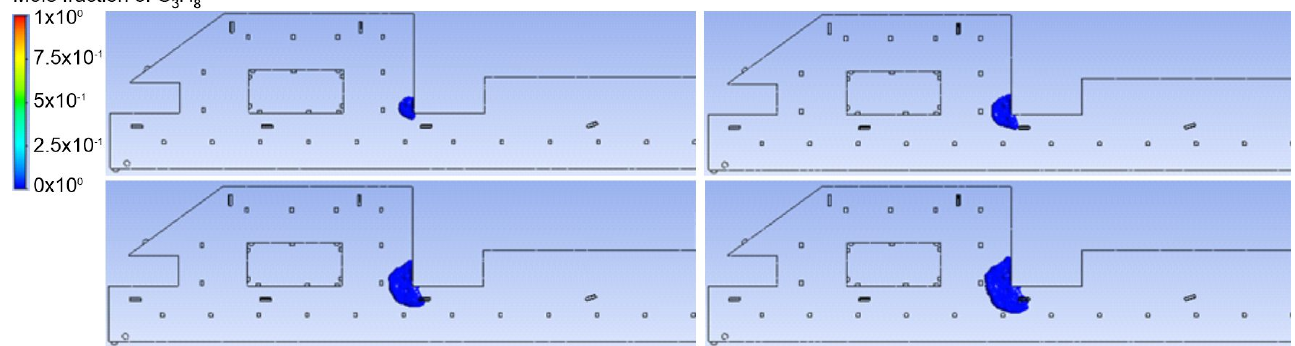
Figure 6. Lower explosive limit of LPG distribution in an underground garage after gas dispersion for B source for different time steps: 2.5 s, 5 s, 7.5 s and 10 s. For longer times, differences in gas dispersion were observed. For A source, a greater area occupied by gas compared to B source was observed. For the A leakage source, the equal to 15 s). Next, the LEL area expanded to 6.1%, 5.6% and 5.1% for 35 s, 55 s and 70 s,